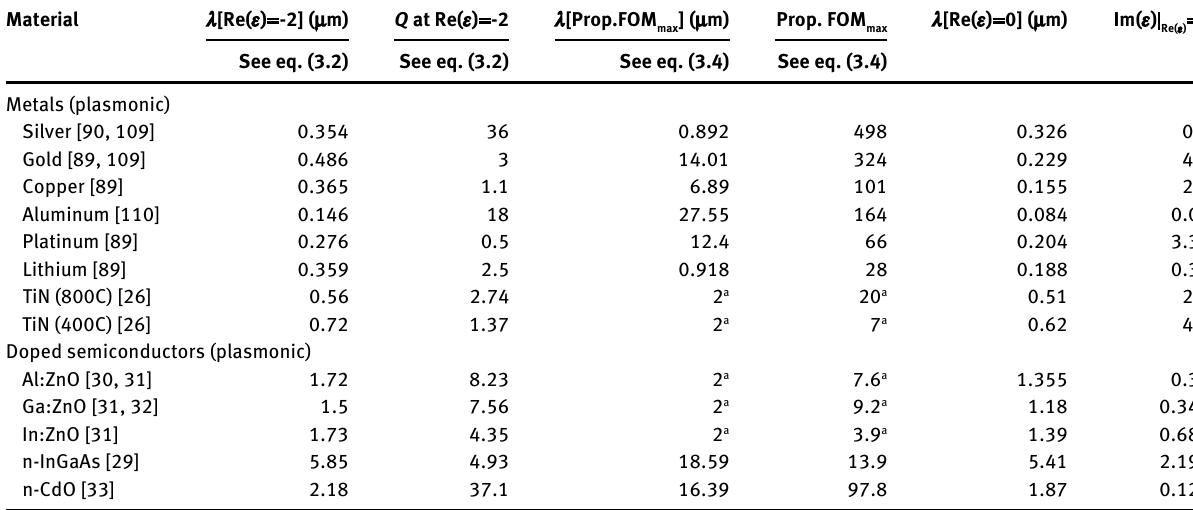
Table 1 Calculated wavelengths and corresponding localized, propagating and ENZ FOMs for plasmonic metals and doped semiconductors discussed in the